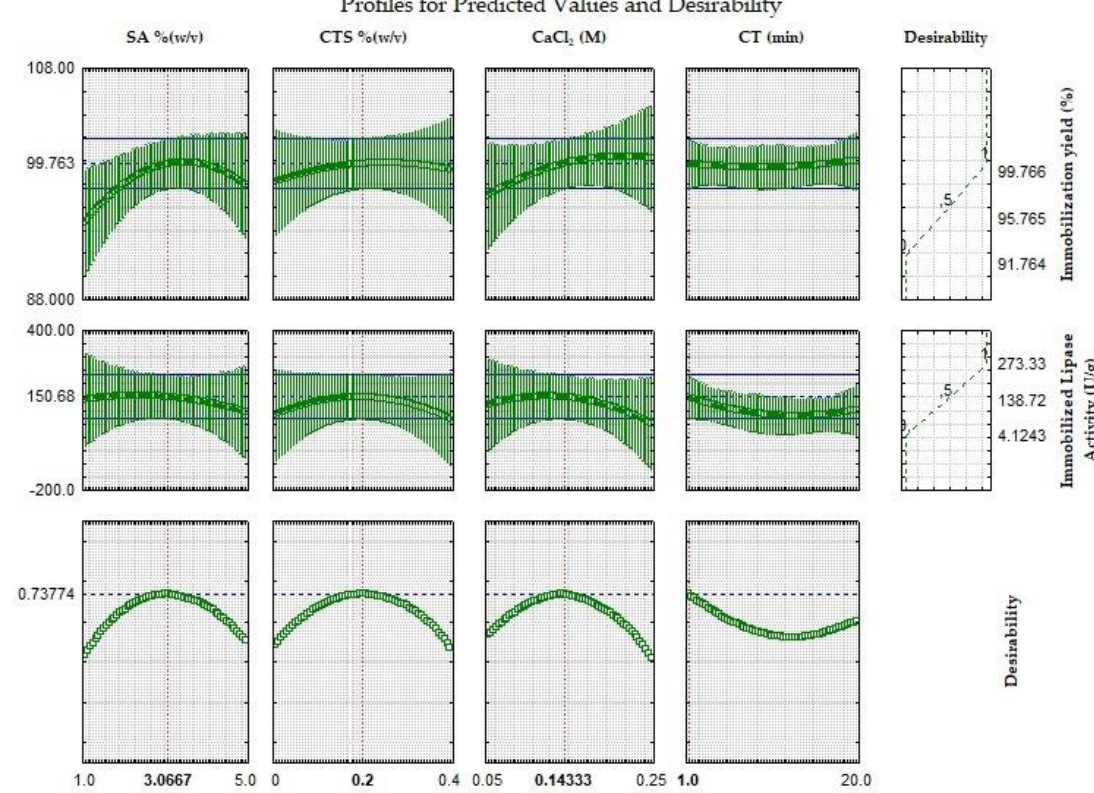
Figure 4. Profile of predicted values and desirability function for immobilization yield and immobilized lipase activity. The dashed vertical line indicates the actual values after optimization.